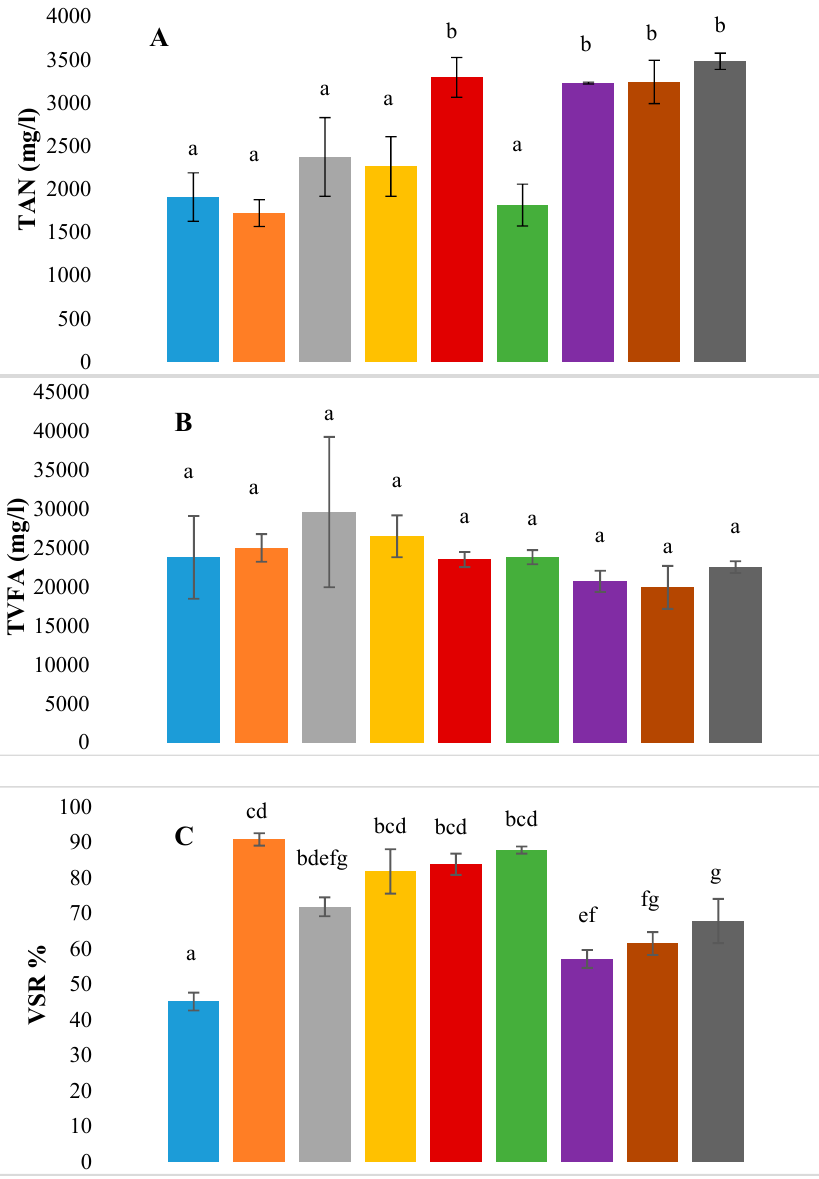
Figure 4. Bar graphs showing final concentrations of ( A ) TAN, ( B ) total VFA and ( C ) volatile solids reduction (%) for all BMP assays -. Control, Enzyme, Trace elements, Selenium, Enzyme with trace elements, Enzyme with Selenium, Enzyme pretreatment, Enzyme pretreatment with trace elements, Enzyme pretreatment with Selenium.